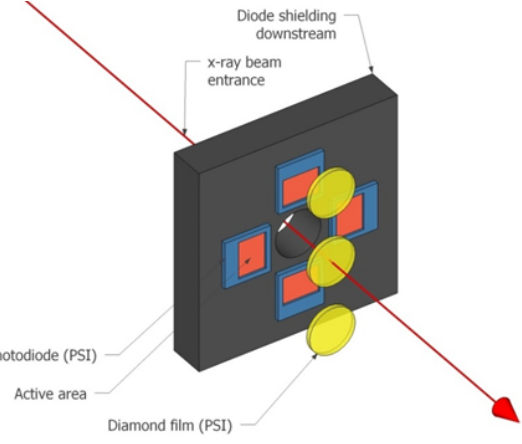
Figure 8. Schematic drawing of the photon backscattering monitor (PBPS)